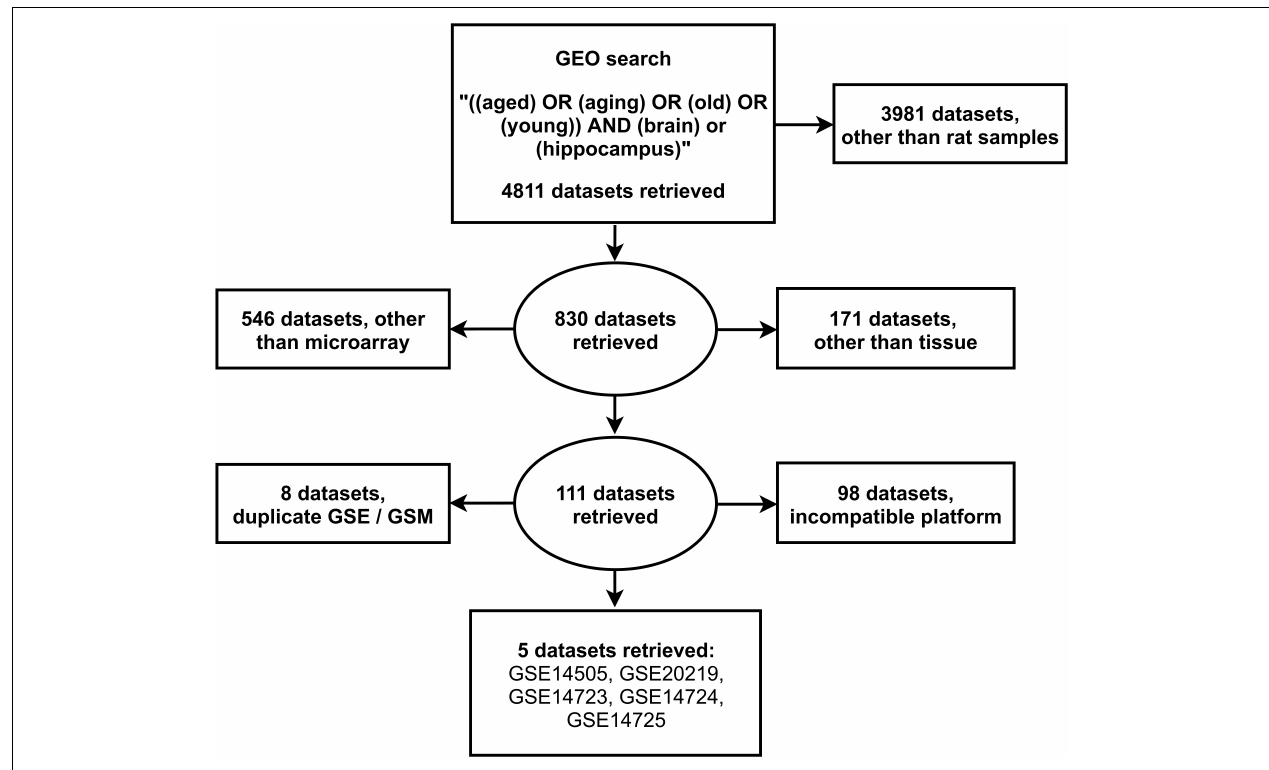
FIGURE 1 | Search strategy for the selection of eligible gene expression datasets from the National Center for Biotechnology Information Gene Expression